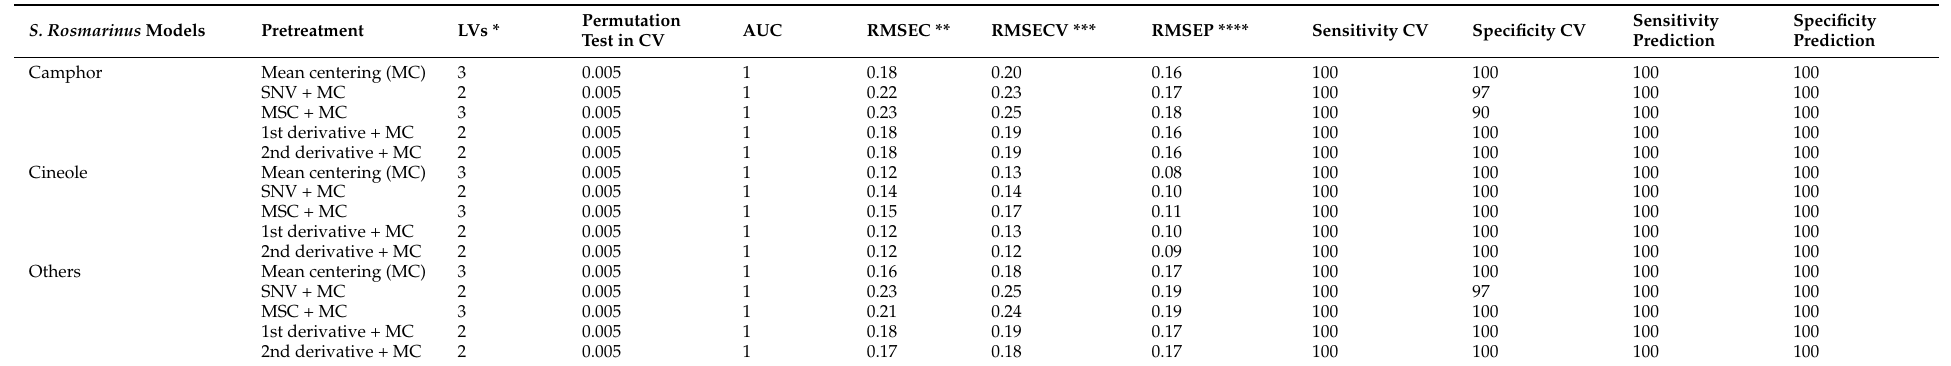
Table 2. Results of PLS-DA models applied on S. Rosmarinus dataset for both cross-validation of the calibration set and prediction of test set using different pretreatment